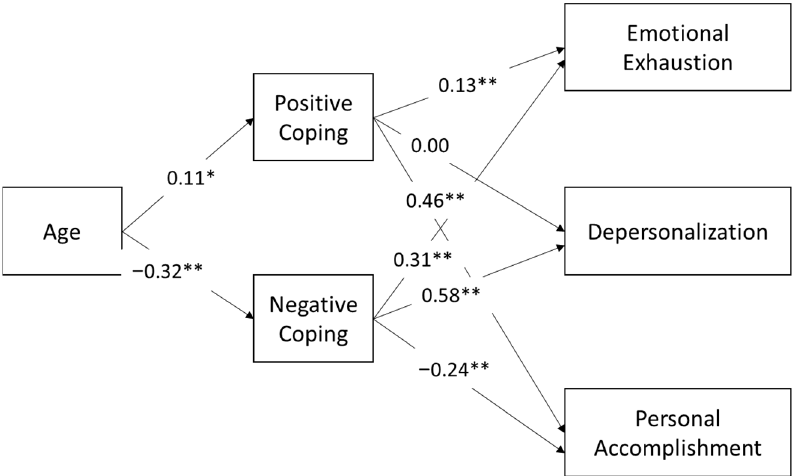
Figure 2. Path analysis of the relationship between age and burnout as mediated by positive and negative coping. * p < 0.05, ** p < 0.01. Table 3. Parameter estimates for mediation model with age as the exogenous variable, coping as mediating variables, and burnout as the outcome variable: Direct effects are shown in the top part of the table; indirect effects are shown in the bottom of the